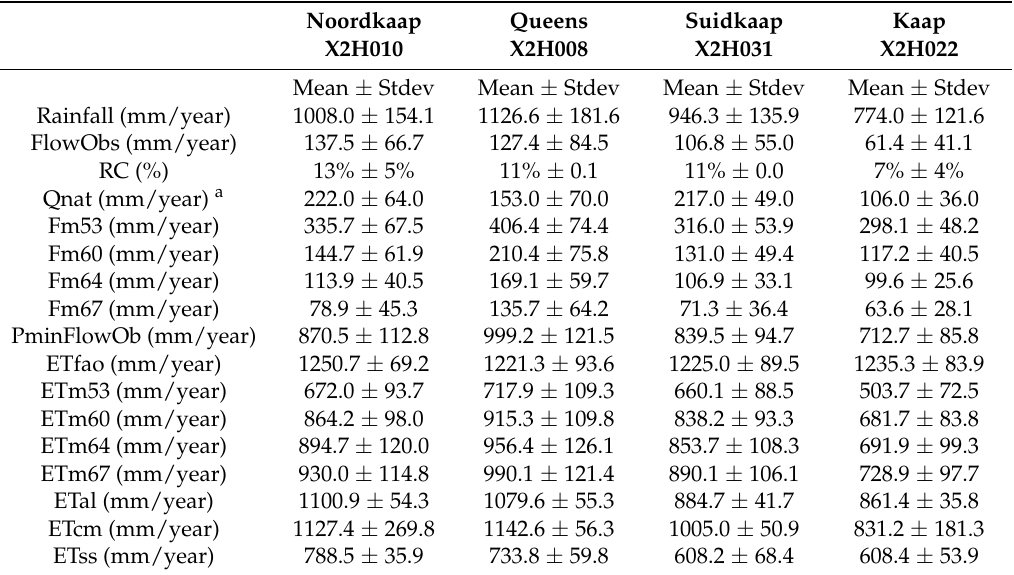
Table 6. Average annual water balance, including evaporation from remote sensing products for comparison, for the period